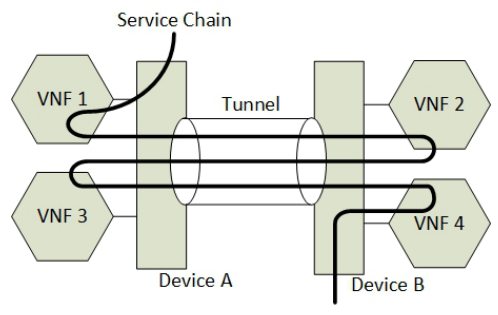
Figure 4. Flow identification